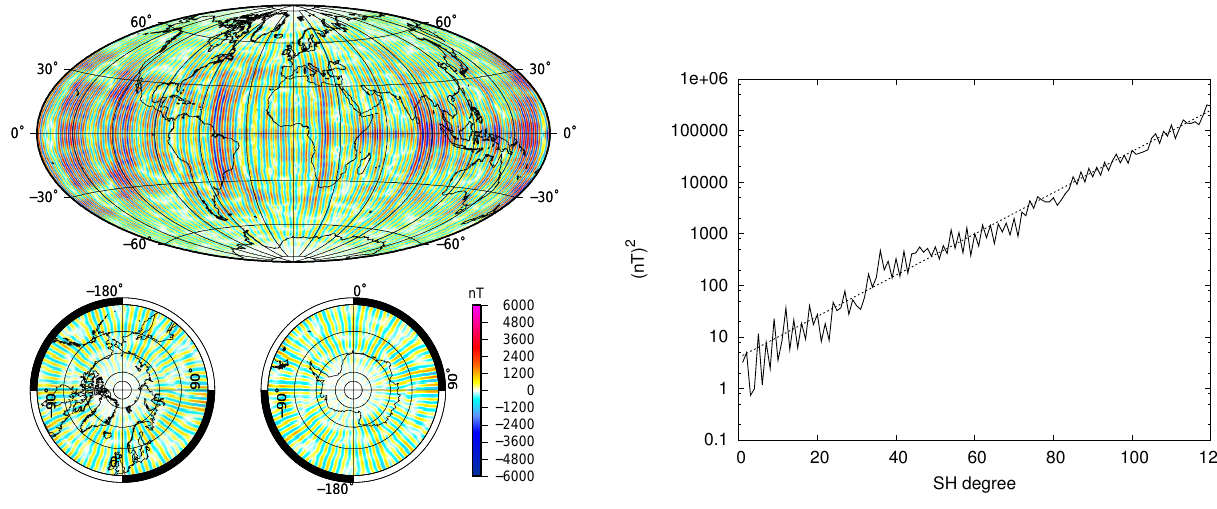
= 1, r = 6671 . 2km – i.e. 300km altitude – and the 1